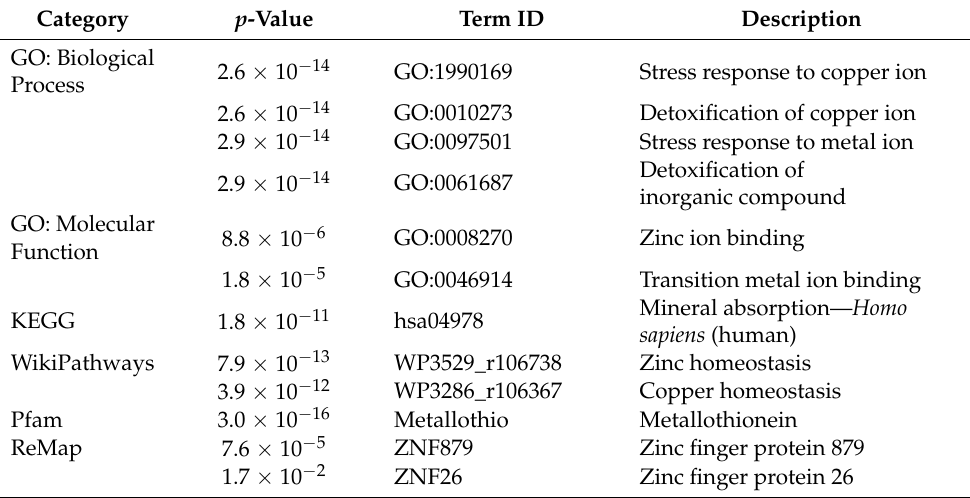
Figure 3. HGCA2.0 MT1M 5 internal node coexpression clade. Table 2. Selected top gene term enrichments of the coexpressed genes to MT1M in HGCA2.0.